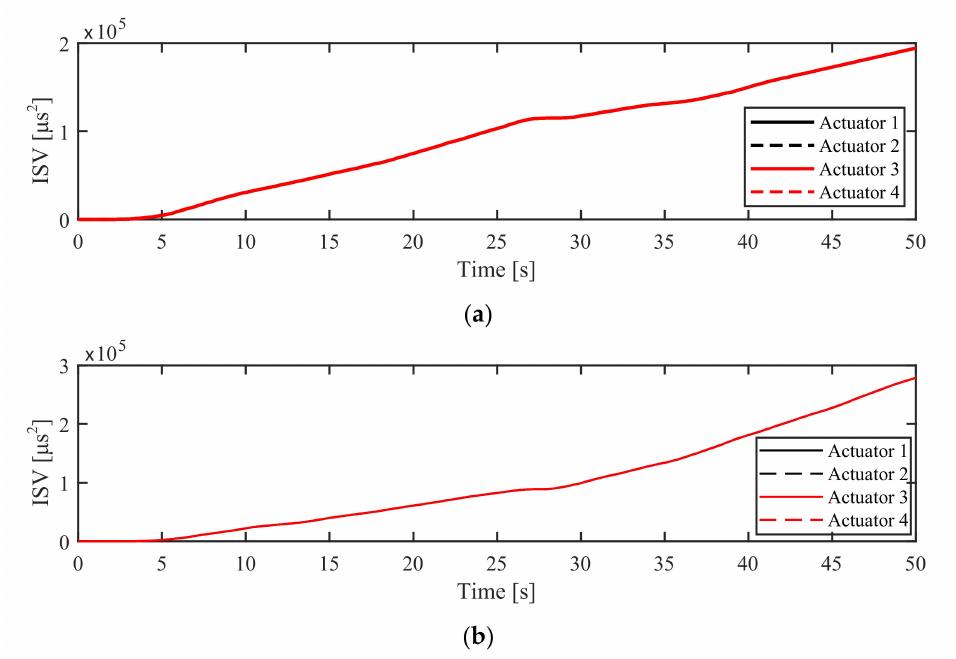
Figure 25. The performance indices: ( a ) ISV values of the proposed controller; ( b ) ISV values of the PID.